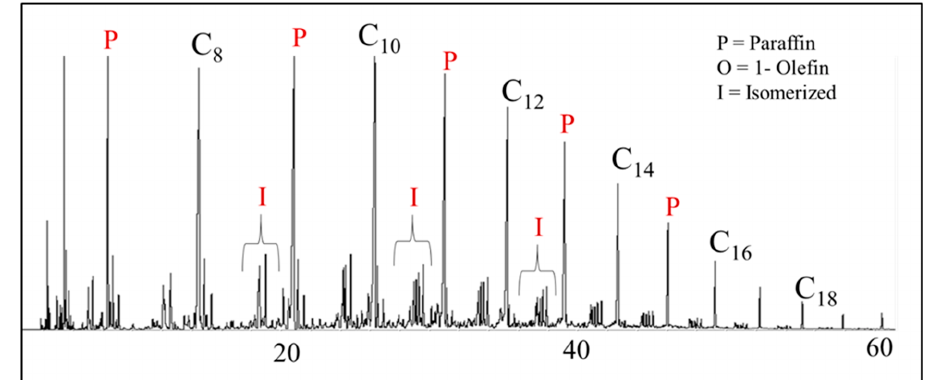
Figure 31. A chromatographic picture of the oil for an 100% iron catalyst. The x -axis is retention time in minutes. Reaction Conditions: 270 °C, 12.1 bar, WHSV = 2, and H 2 /CO = 0.7.